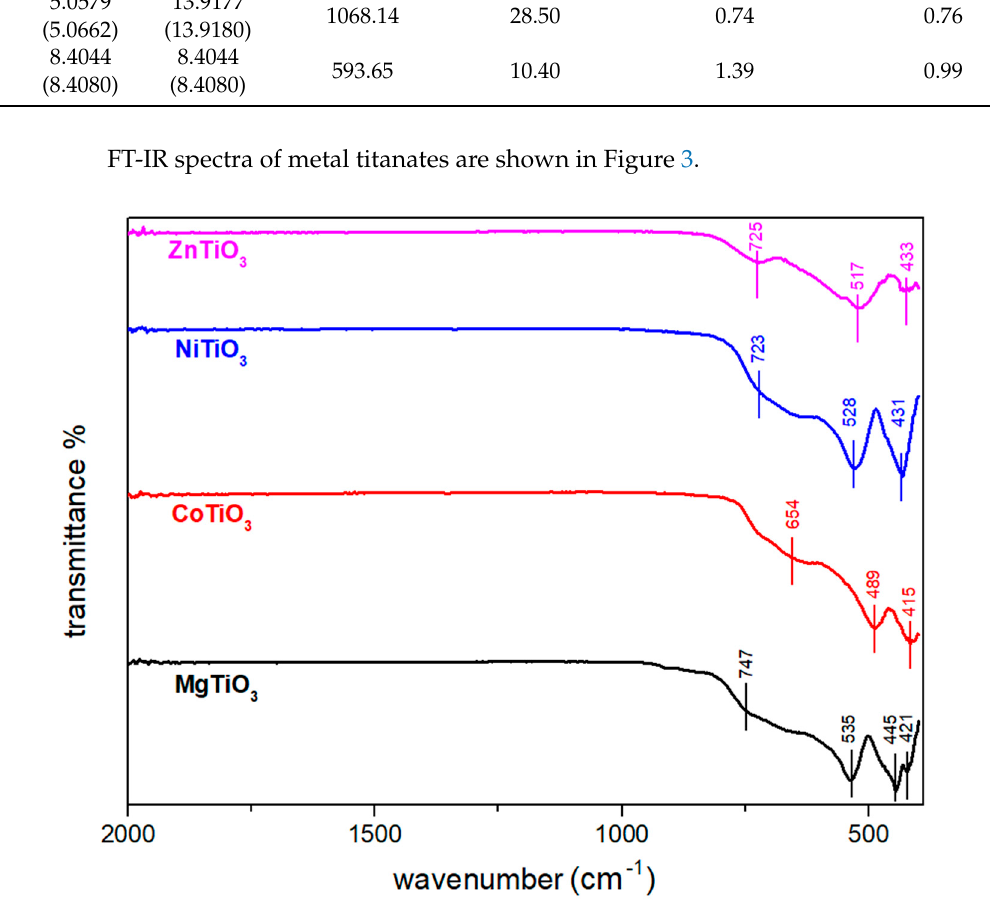
Figure 3. FT-IR spectra of metal titanate nanorods ATiO 3 (A = Mg, Co, Ni, Zn) after annealing pro- cess.